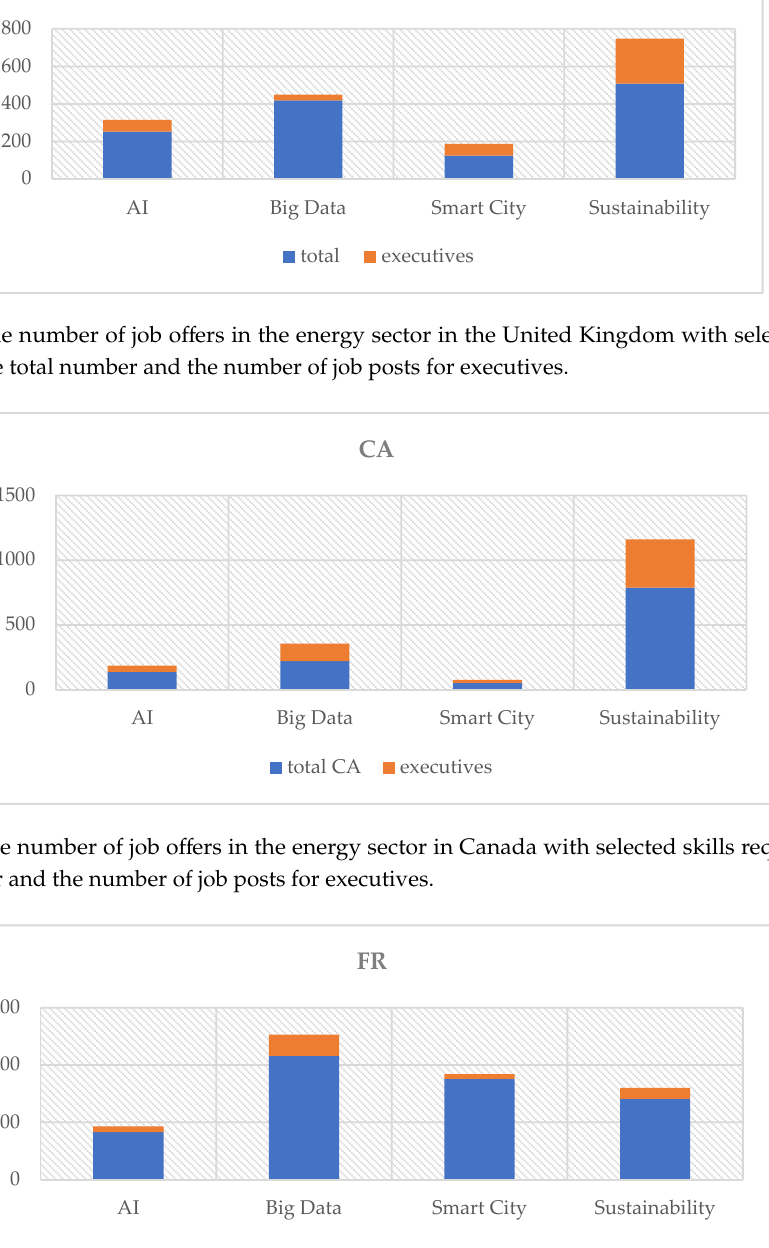
Figure 7. The number of job offers in the energy sector in France with selected skills required: the total number and the number of job posts for executives.